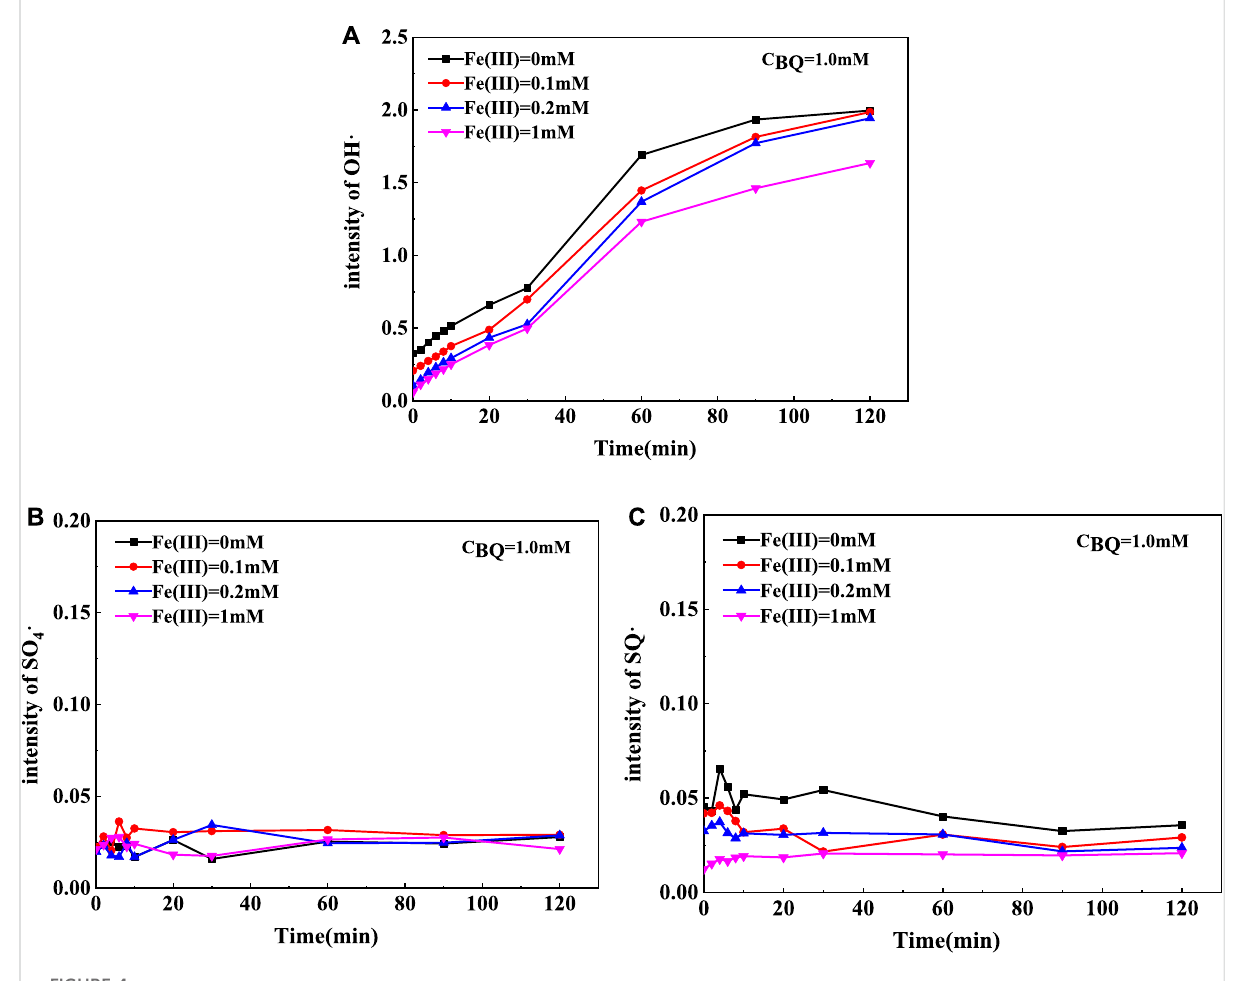
FIGURE 4 The response intensity of free radicals in BQ/Fe ( Ⅲ )/PS system with DMPO spin trapping agent: (A) OH · , (B) SO 4 · - , (C) SQ · -